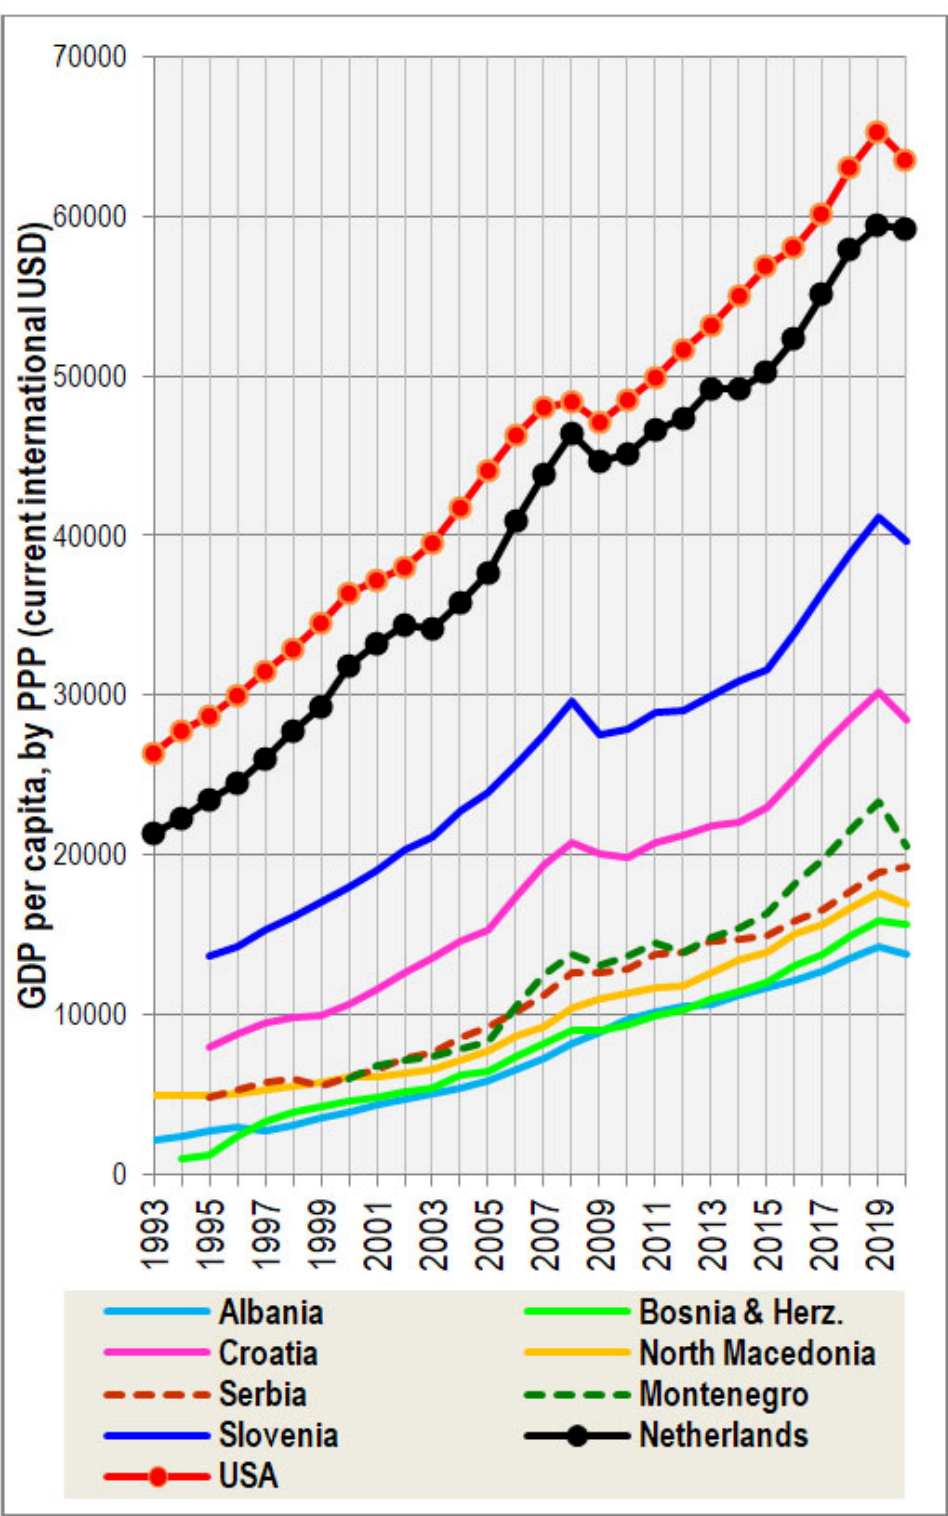
Figure 3. Economic development in the Western Balkans (gross domestic product per capita, by purchasing power parity), compared with the Netherlands and the USA. Source: [23].